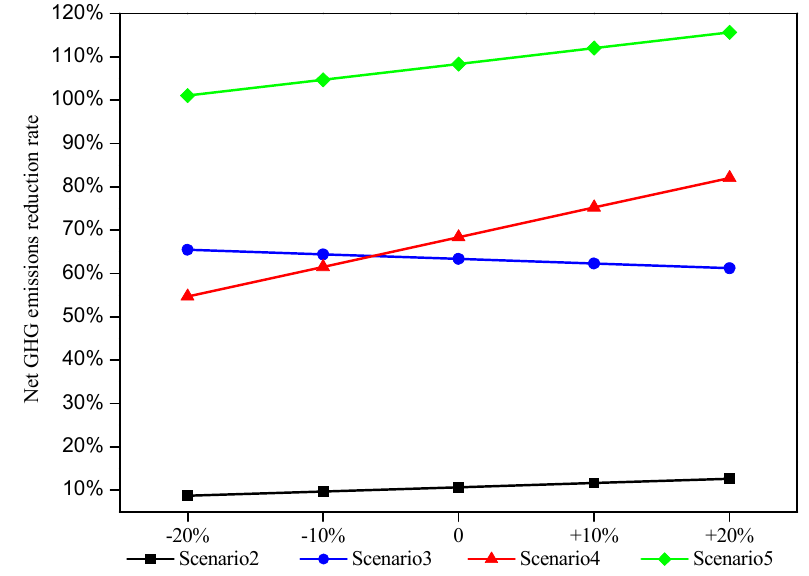
Figure 12. The relationship between separation rate and net GHG emission reduction rate.